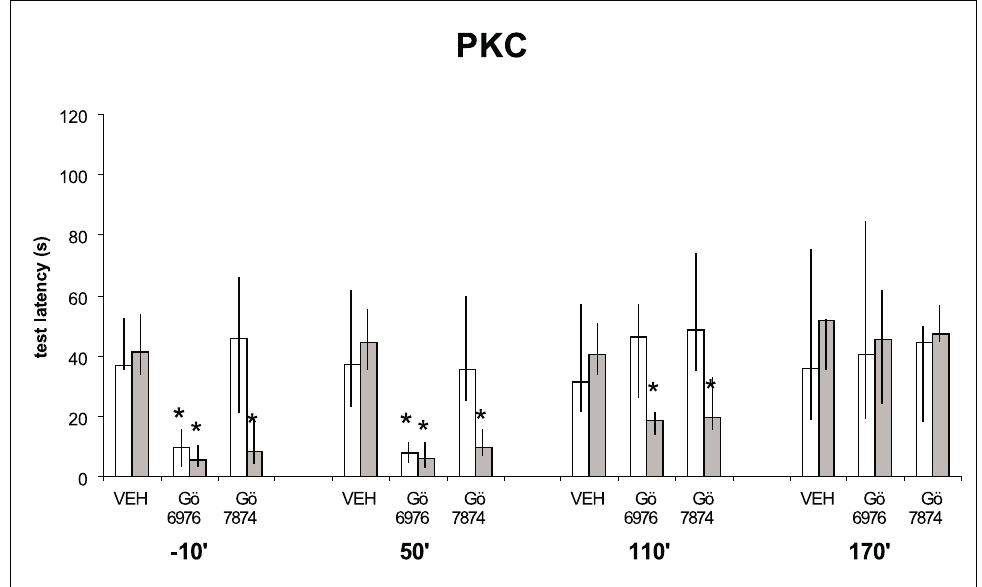
Fig. 3 – Same procedures as in Figure 1. Data from this figure is published elsewhere (Vianna et al. 2000b). Rats received bilateral infusions in the dorsal CA1 region of vehicle, of the selective inhibitor of the PKC α and β I isoforms, Gö 6976 (4.6 nM), or of the generic inhibitor of the PKC, Gö 7874 (8 nM). The infusions were given 10 min before or 50, 110 or 170 after training. STM testing was at 180 min after training. ∗ Indicates significant difference from control values at p < 0 . 001 level. In groups not marked by asterisks the training- test latency differences were significant at a p < 0 . 001 level. The selective α and β I PKC inhibitor given 10 min before or immediately after inhibited both STM and LTM, given 110 min after training it only partially inhibited LTM. The generic PKC inhibitor in-hibited only LTM, when given 10 min before and 50 min after training. It also had a less intense amnestic effect when infused 170 min after